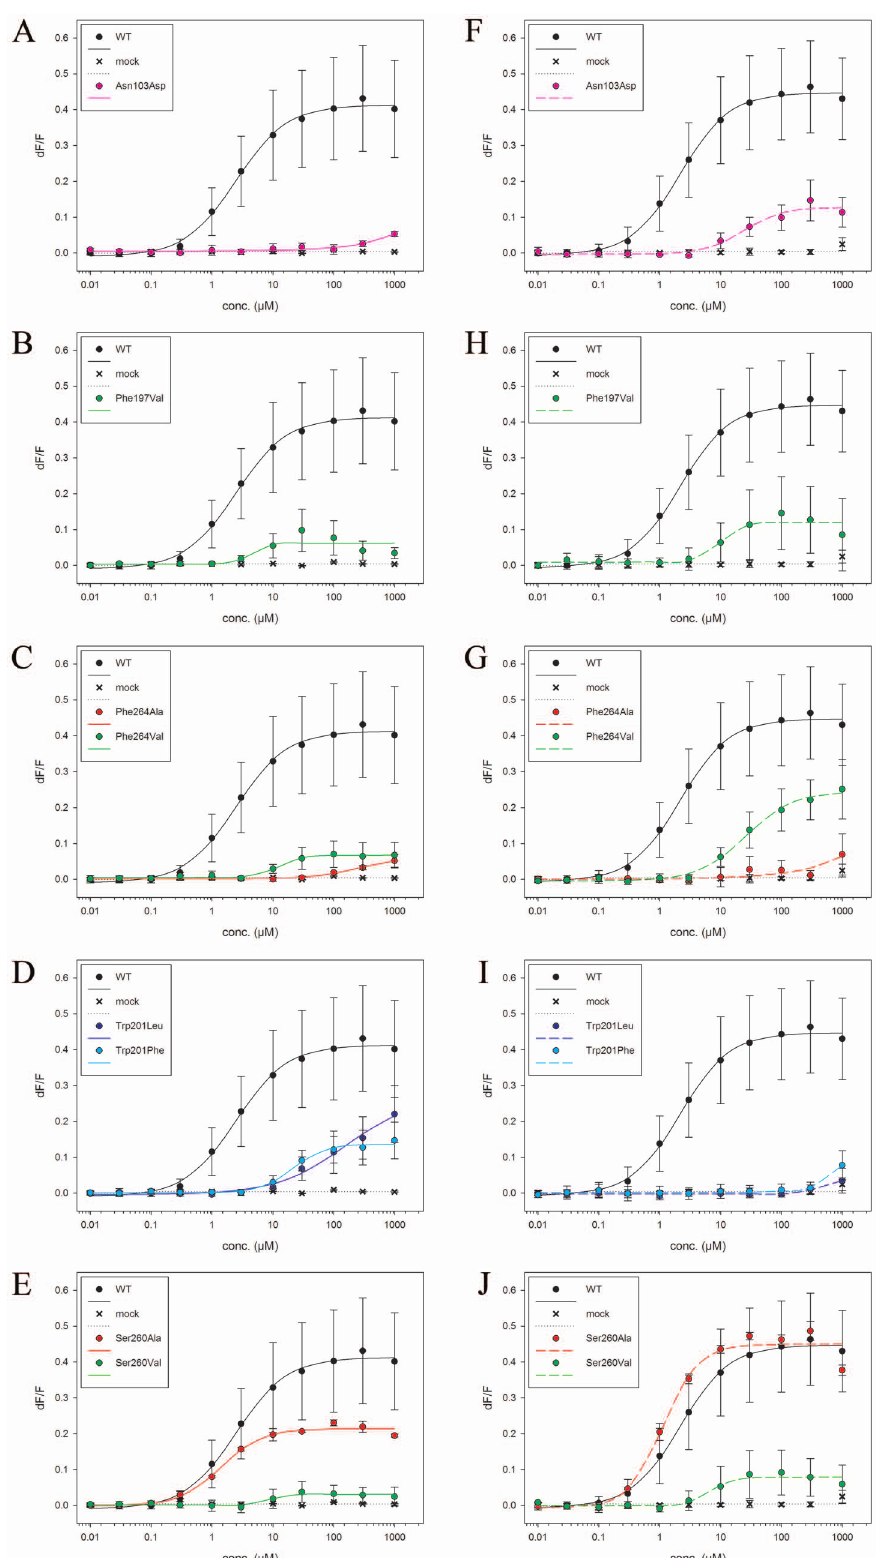
Figure 6. Dose-response curves. Dose-response curves of TAS2R38 wild type and mutants after stimulation with increasing PTC and PROP concentrations (0 to 1000 m M). Each point corresponds to the mean 6 standard deviation. The mean is calculated from at least three independent experiments. A-E) PTC application, F-J) PROP application.